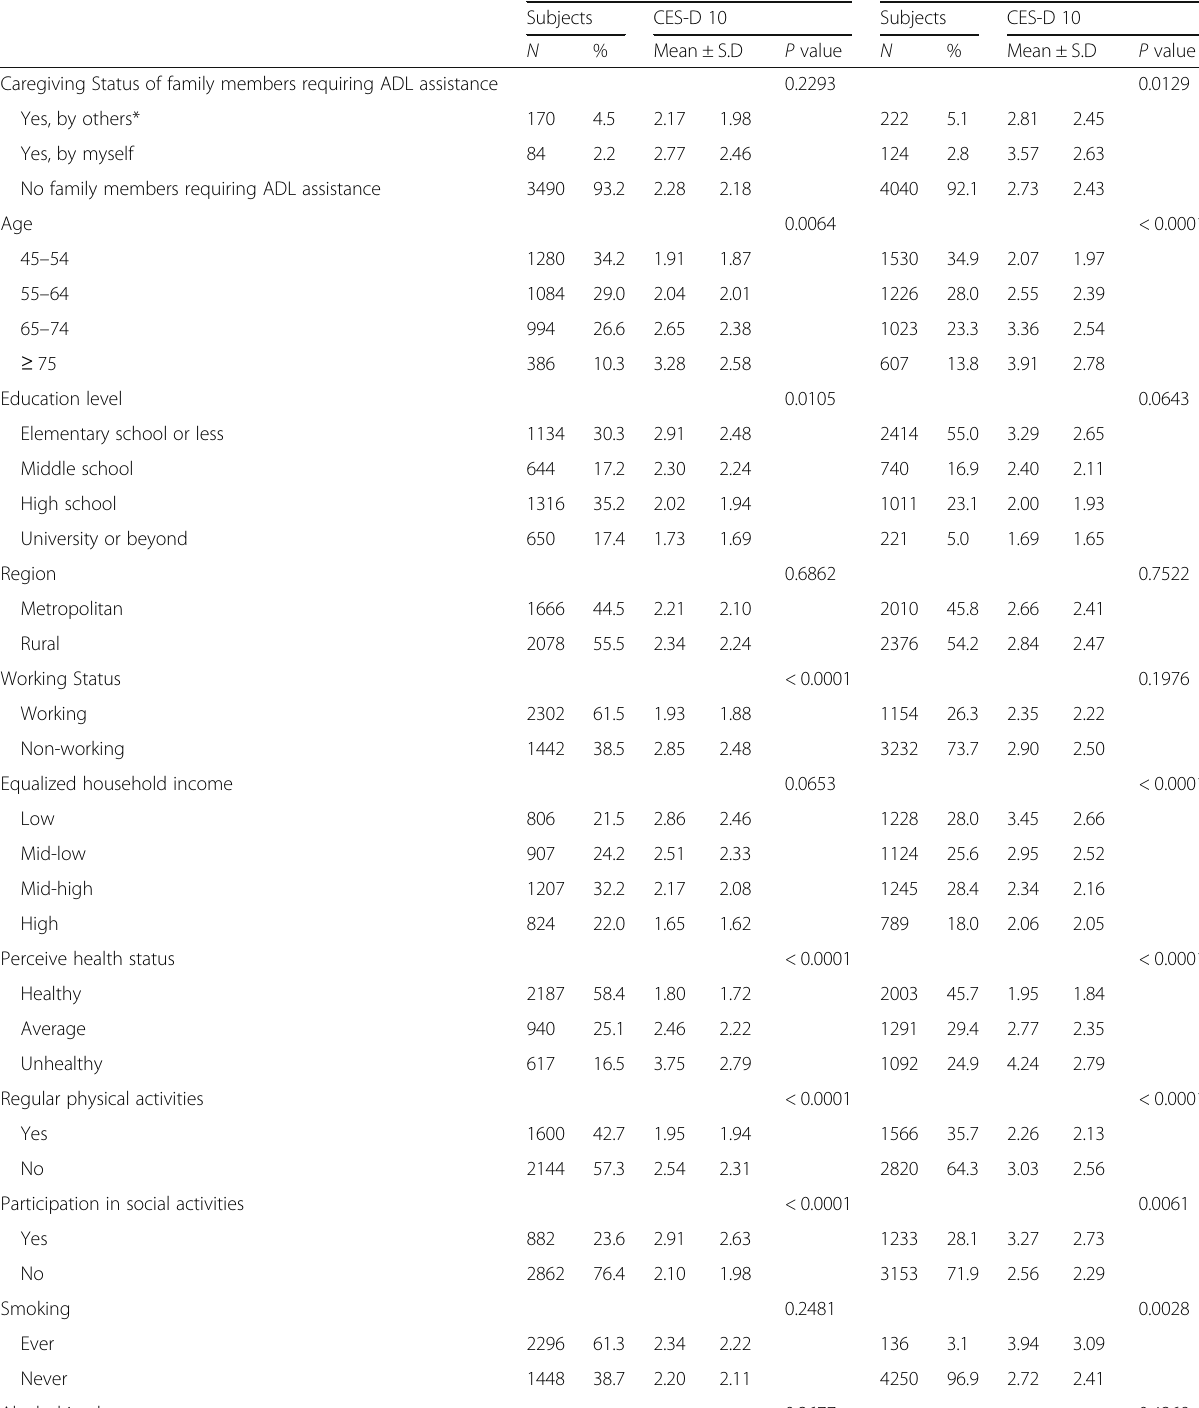
Table 1 Baseline characteristics of the study population by CES-D 10 Variables Men Women Subjects CES-D 10 Subjects CES-D 10 N % Mean ± S.D P value Mean ±